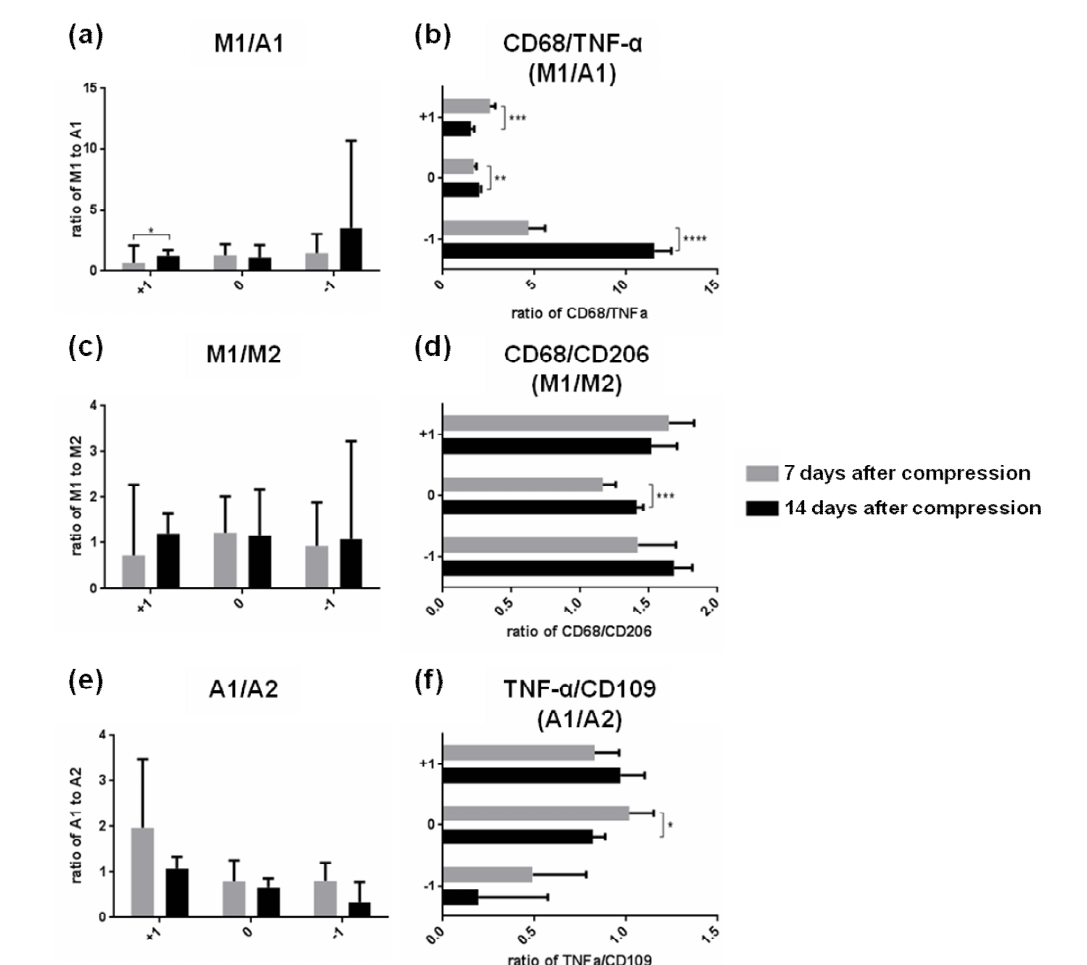
Figure 7. Microglia–astrocytes crosstalk at the injury site and in surrounding areas one and two weeks after SCI. ( a , b ) Graphs show ratios between overall neurotoxic M1 microglia markers and pro-inflammatory A1 astrocytes and their strongest representative markers (CD68 and TNF- α ). ( c , d ) Ratios between neurotoxic vs neuroprotective phenotypes of microglia M1/M2 and their strongest representative markers (CD68 and CD206). ( e , f ) Ratios between neurotoxic vs neuroprotective phenotypes of astrocytes A1/A2 and their strongest representative markers (TNF- α /CD109). Error bars represent SD. Statistical significance was determined with parametric t -test (* p < 0.05; ** p < 0.01; *** p < 0.001; **** p < 0.0001). SCI—spinal cord injury; CD68—cluster of differentiation 68; TNF- α —tumor necrosis factor- α ; CD206—mannose receptor and C-type lectin; CD109—Cluster of differentiation